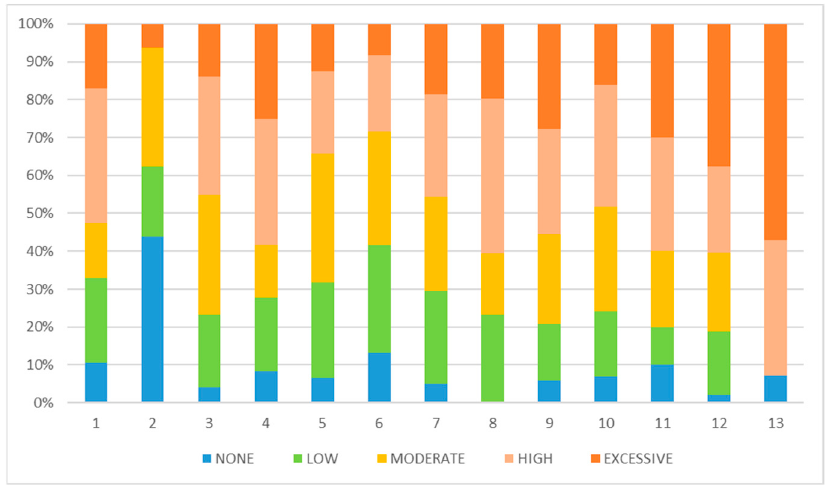
Figure 5. Beach users’ perceptions of the degree of impact of different litter categories/types.